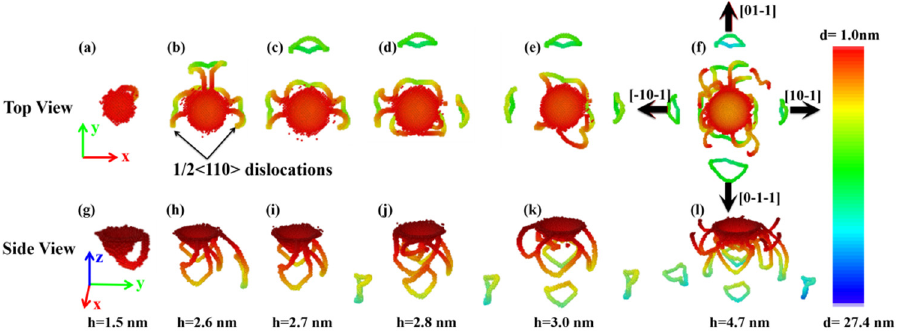
Figure 9. The microstructure evolution under the indented (001) plane of ZnSe nano film at different indentation depth. Atoms are colored with z-value. ( a ), ( b ), ( c ), ( d ), ( e ), and ( f ) are the top views of the structures at the indentation depth of 1.5 nm, 2.6 nm, 2.7 nm, 2.8 nm, 3.0 nm, and 4.7 nm, respectively. ( g ), ( h ), ( i ), ( j ), ( k ), and ( l ) are the side views of the structures at the indentation depth of 1.5 nm, 2.6 nm, 2.7 nm, 2.8 nm, 3.0 nm, and 4.7 nm, respectively.